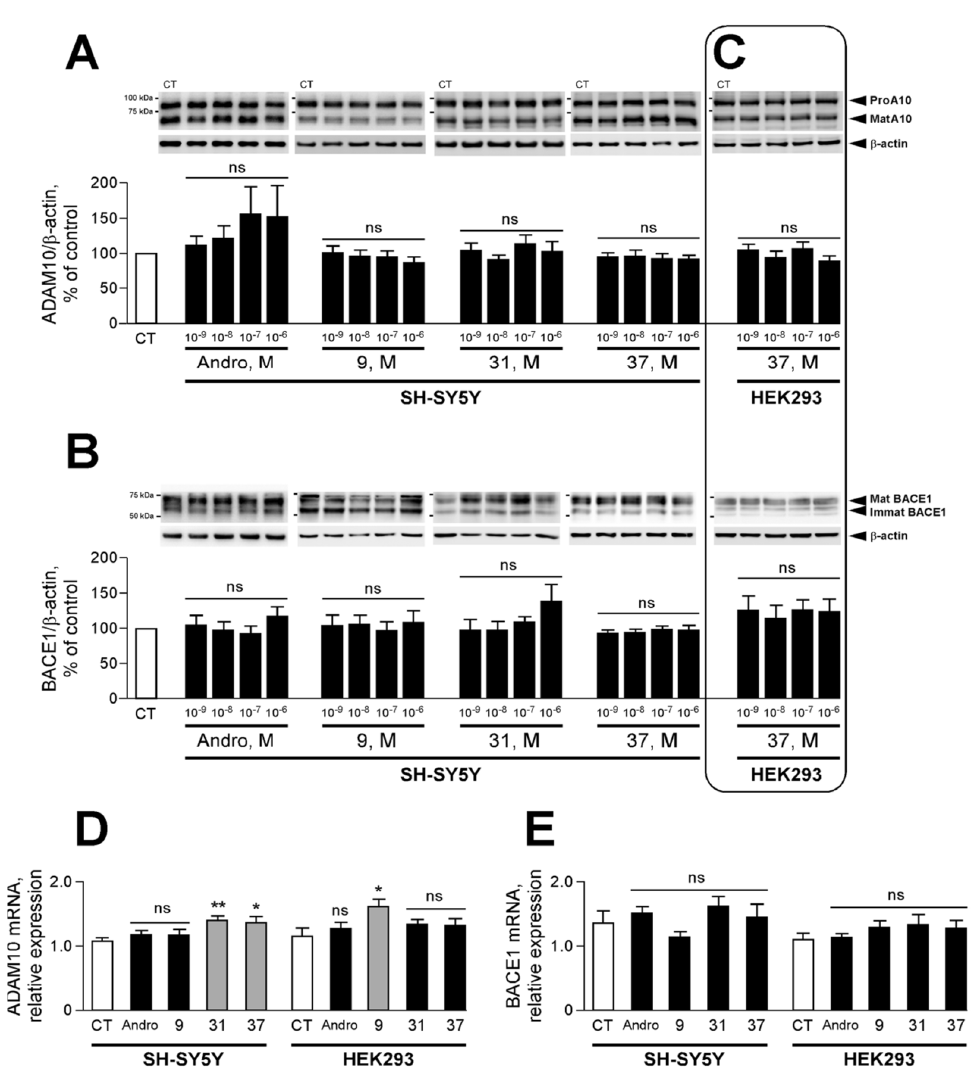
Figure 5. Effects of andrographolide and compounds 9 , 31 , and 37 on ADAM10 and BACE1 expres- sion in human cells. ADAM10 and BACE1 protein ( A – C ) and mRNA ( D , E ) levels were measured (by Western blot and real-time qPCR, respectively) in the indicated cell lines following treatment without (control, white bar) or with various concentrations of the compounds (1 nM to 1 μ M). Bars are the densitometric analyses, are expressed as a percentage of control (white bars, non-treated cells), and are the means ±SE of 11 to 18 (Western blots) and 4 (qPCR) independent determinations. * p < 0.03; ** p < 0.01 (gray bars); ns, no statistical difference (black bars). The upper parts of panels A and B illustrate representative gels.